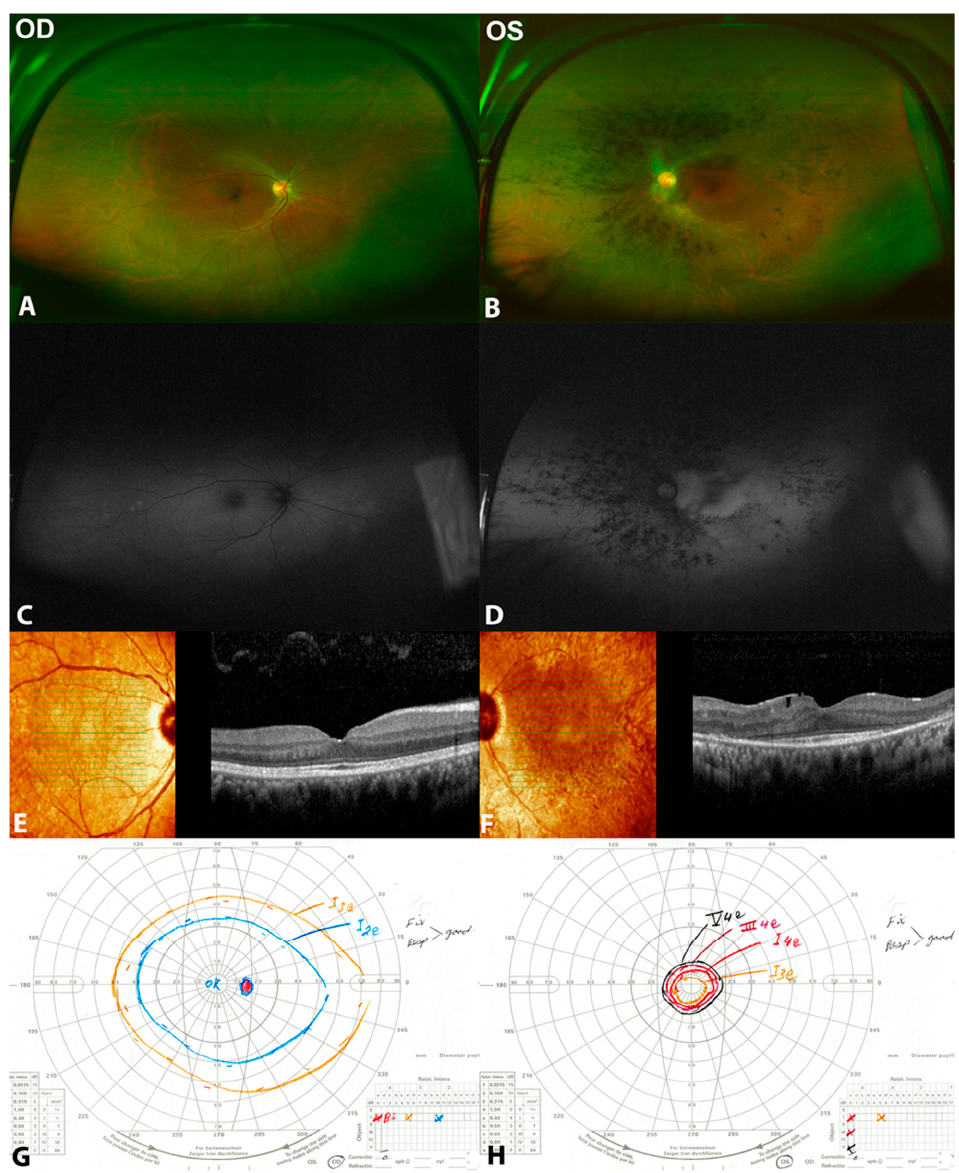
Figure 1. Clinical and multimodal findings of (patient 1) a 32-year-old female with unilateral retinitis pigmentosa (URP) in the left eye with two heterozygous variants c.373 C>T (p.Arg125Trp) and c.730-22_730-19 dup in AGBL5 . ( A , B ) are color fundus photos showing normal right eye, while they show midperipheral bone spicules more condensed nasally, attenuated blood vessels, and pale disc. ( C , D ) are fundus autofluorescence photos showing normal right eye and hypoautofluorescence corresponding to the bone spicules, hyperautofluorescence at the macular area with reserved foveal autofluorescence in the left eye. ( E , F ) are spectral domain optical coherence tomography (SD-OCT) showing normal right eye. However, there is a peripheral loss of the ellipsoid zone with foveal sparing in the left eye. ( G , H ) are Goldmann visual fields showing normal visual field in the right eye and tunnel visual field in the left